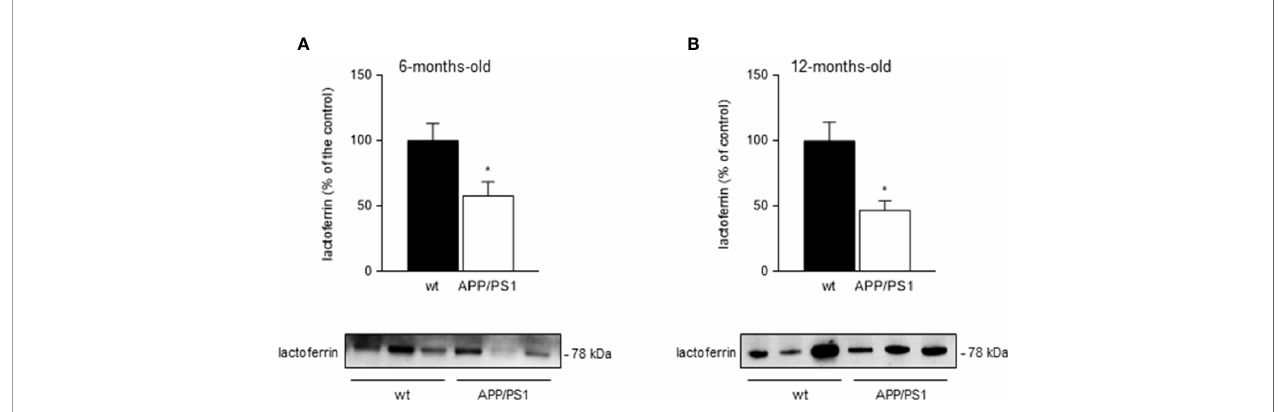
FIGURE 1 | Salivary lactoferrin levels in APP/PS1 and WT mice. (A, B) Western blot analysis showed that lactoferrin levels were reduced in the submandibular gland samples from (A) 6- and (B) 12-month-old APP/PS1 compared with WT mice ( n = 8-15, per group). Representative Western blots (lower panels) and histograms with their densitometric analysis (upper panels) are shown. Data are represented as mean ± SEM. Differences between groups were assessed using the Mann- Whitney test. *p <